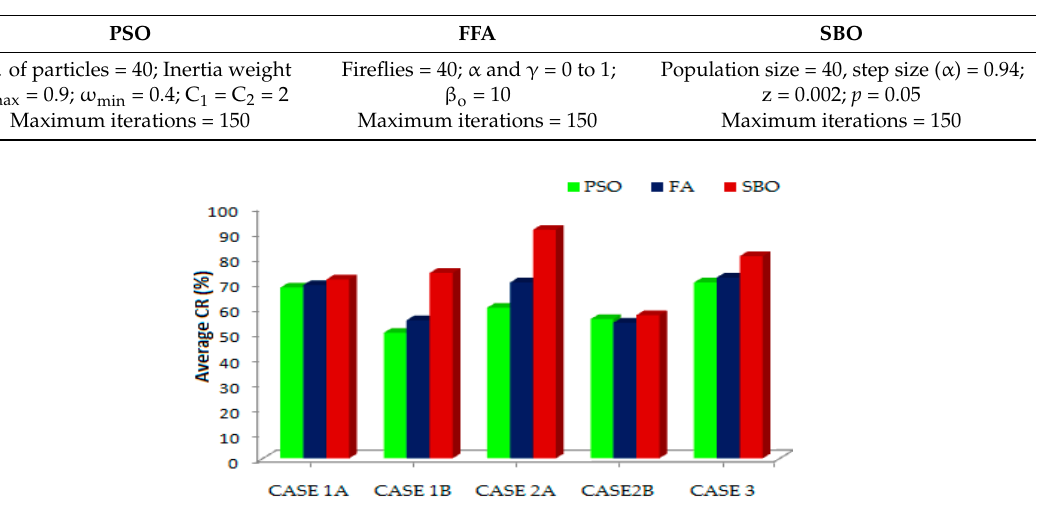
Table 6. Parameter values of various algorithms. FFA: firefly algorithm.